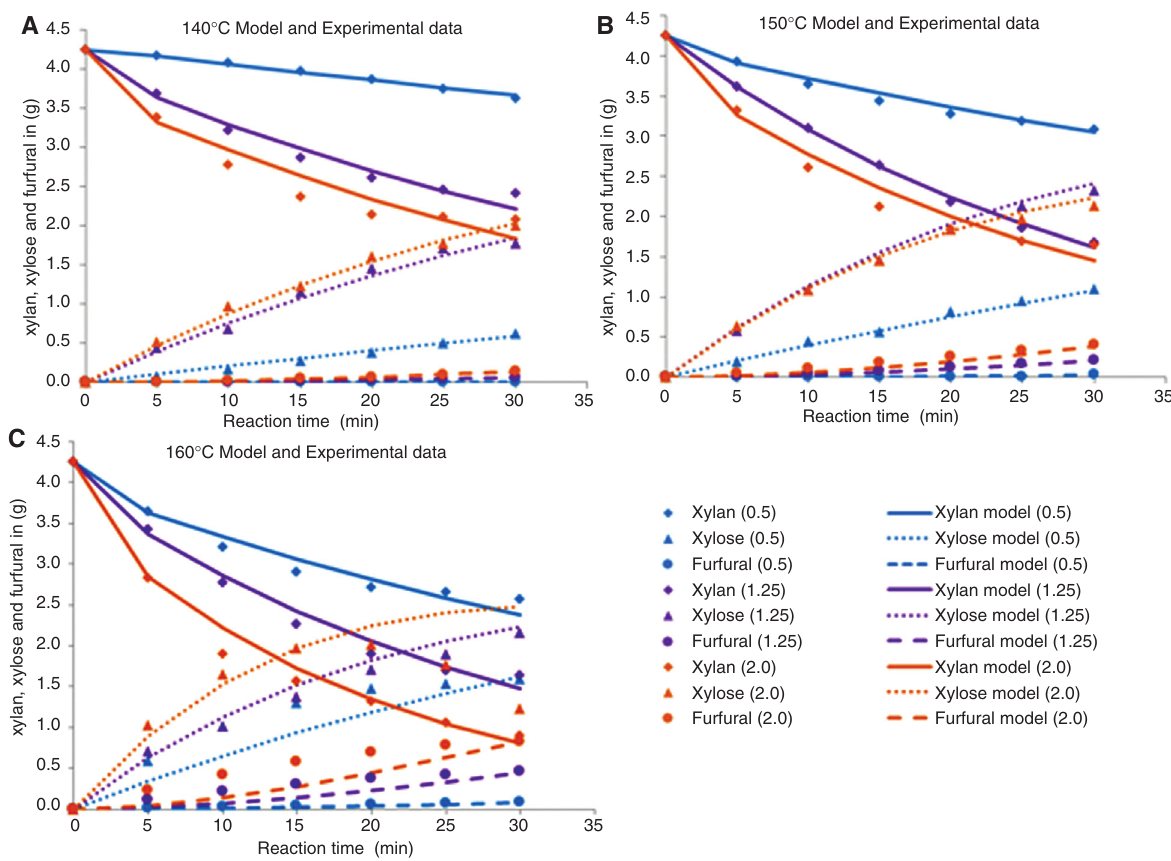
Figure 1 Model and experimental data for xylan, xylose and furfural for sun hulls: (A) pretreated at 140 ° C at 0.5 wt%, 1.25 wt% and 2.0 wt% acid concentrations for hulls; (B) pretreated at 150 ° C at 0.5 wt%, 1.25 wt% and 2.0 wt%; and (C) pretreated at 160 ° C at 0.5 wt%, 1.25 wt% and 2.0 wt%.